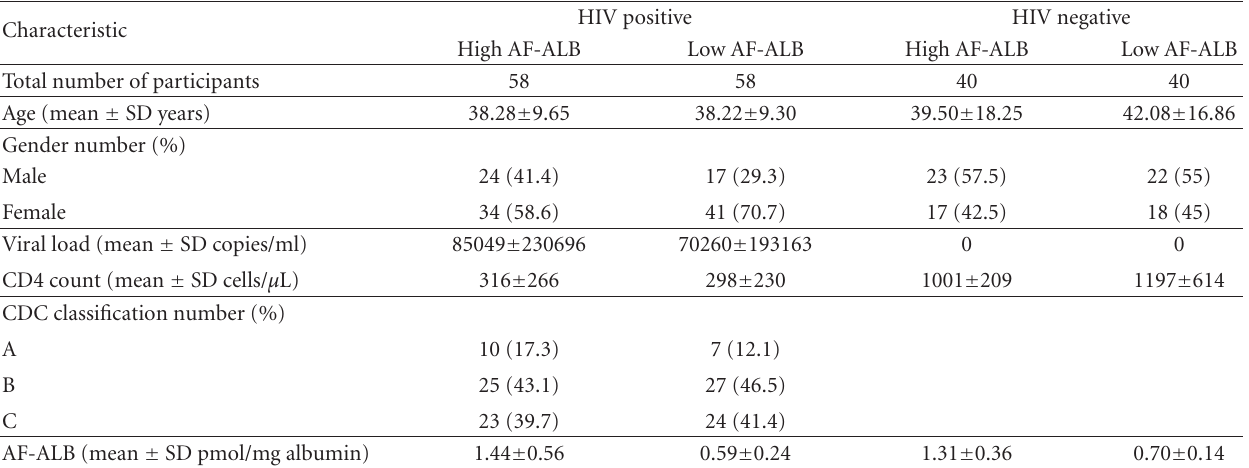
Table 1: Demographic and clinical characteristics of HIV positive and HIV negative study